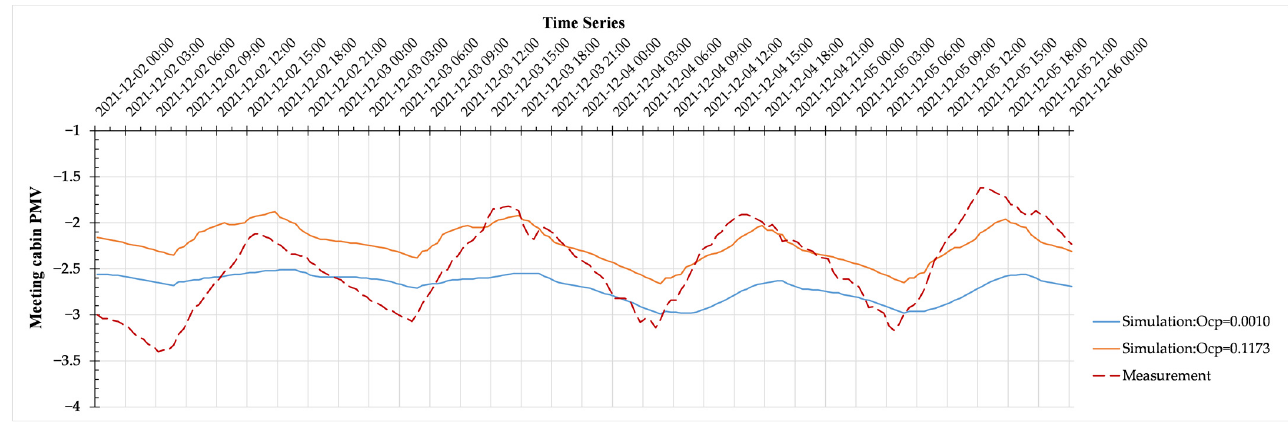
Figure B1. Meeting cabin: predicted mean vote between 2 and 5 December 2021. Figure A1. Meeting cabin: predicted mean vote between 2 and 5 December 2021.